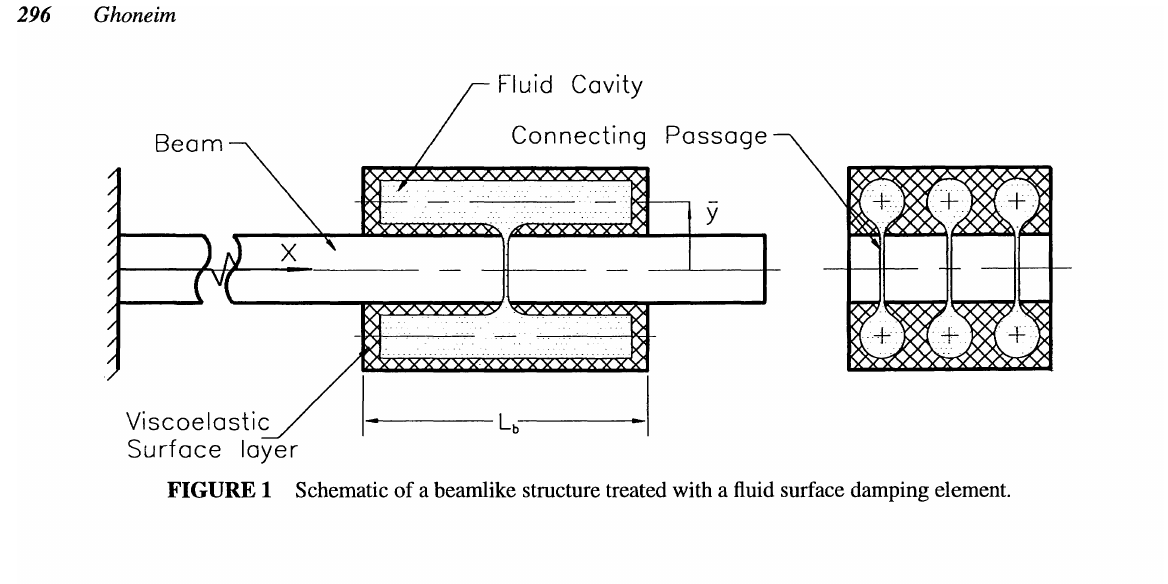
FIGURE 1 Schematic of a beamlike structure treated with a fluid surface damping